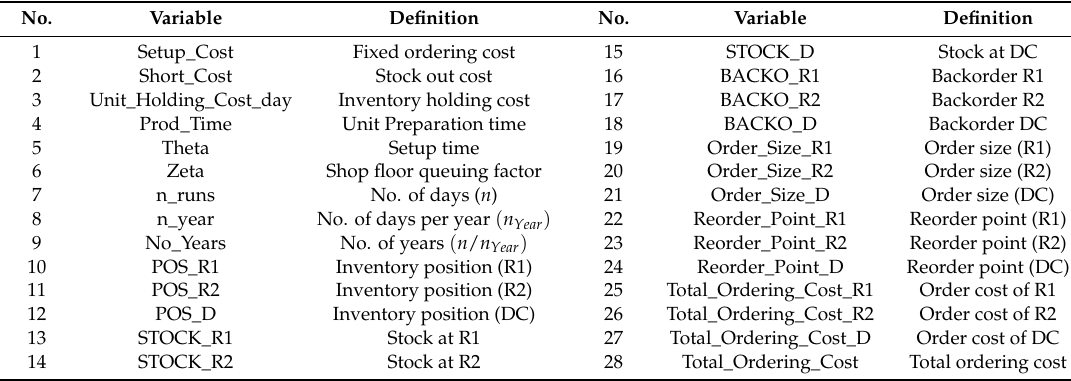
Table 1. Parameter definitions in the “Variable module”.